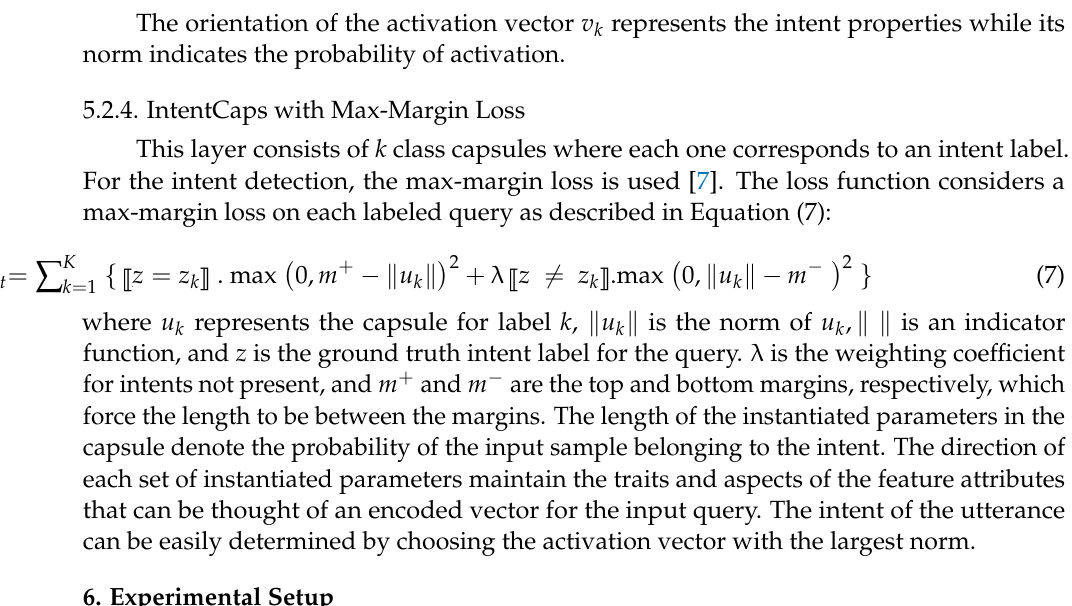
Table 7. Intent-wise division of Urdu web queries dataset in train and test sets. Sr. No.